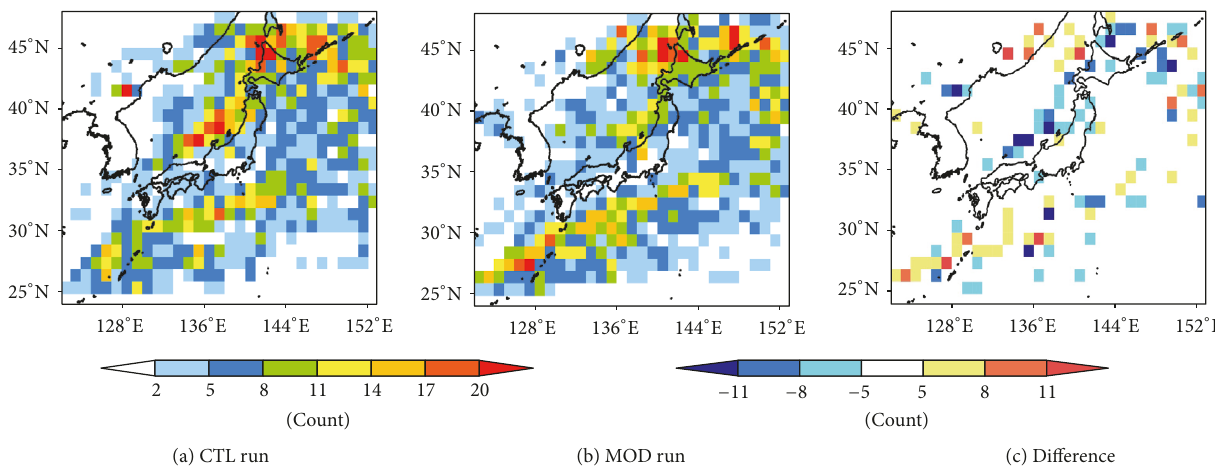
Figure 4: (a) Frequency distribution of synoptic-scale cyclone tracks during 2000–2014 for the CTL run. (b) As in Figure 4(a) but for the MOD run. (c) Difference in cyclone track frequency between the MOD and CTL runs (former minus latter).